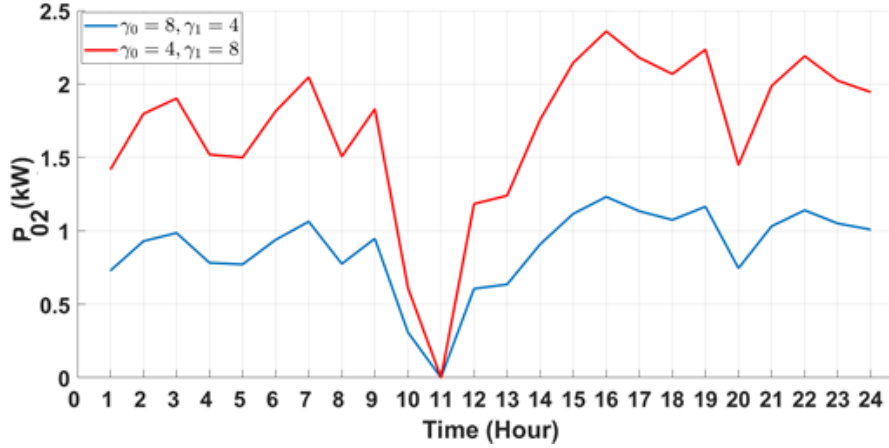
ff erent values of γ